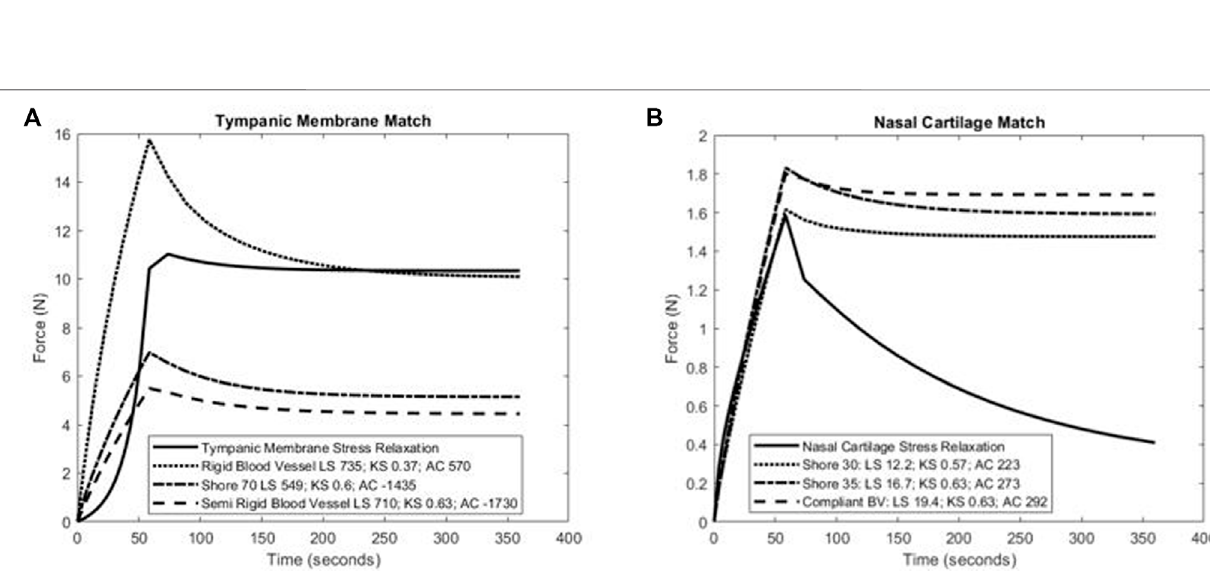
FIGURE 6 | Ranking of J750 3D printed Shore, the DAP bloodvessel materials, and the DAP structural heart materials for the degree of force relaxation over time.